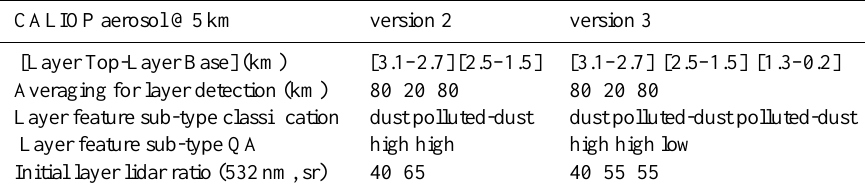
Table 4. 4 August 2007 – Version 2 and version 3 CALIOP 5km-aerosol layer products (layer top and base altitude, averaging required to detect each layer, layer feature sub-type classification and quality assurance) for the closest 5km-profile to CATZ-Sanders along the CALIOP